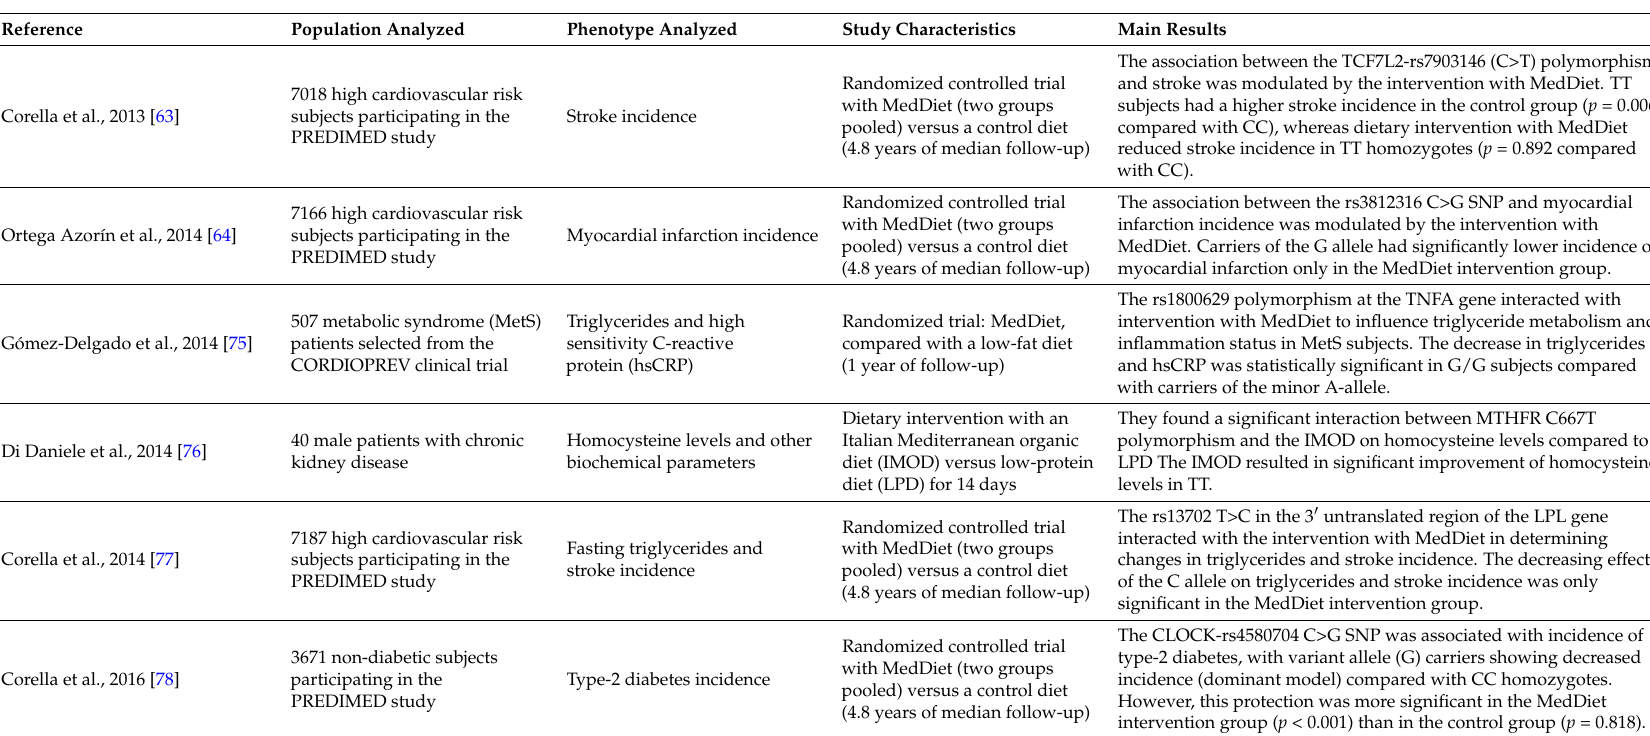
Table 3. Intervention studies with Mediterranean diet (MedDiet) and modification of the intervention effect by genetic variants on cardiovascular risk factors and